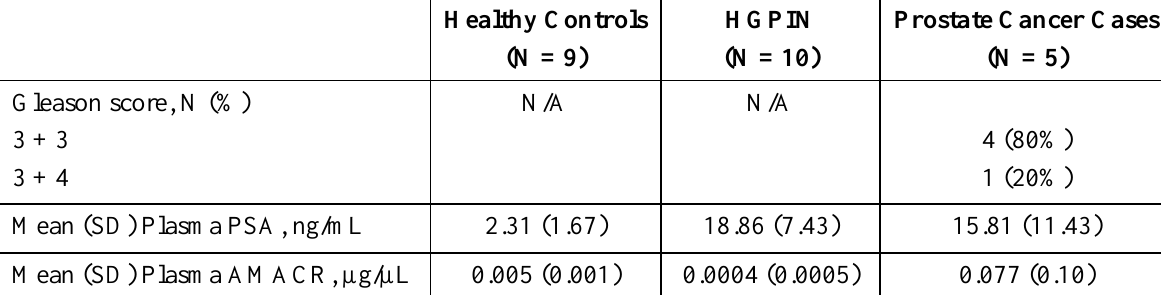
Table 1. Population description and mean AMACR levels by patient